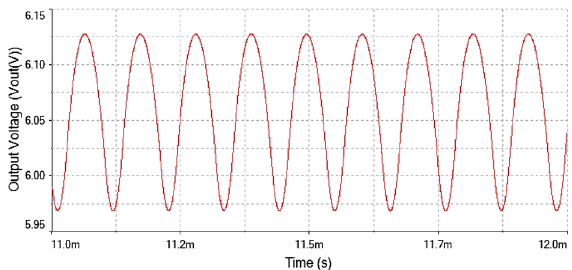
Figure 19. Output voltage waveform for forward converter at R L = 4 (cid:31) .